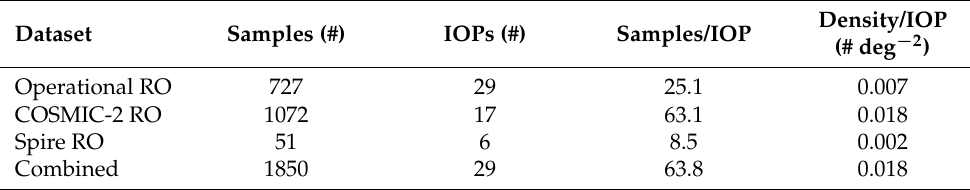
Table 2. Observation sampling and density within an